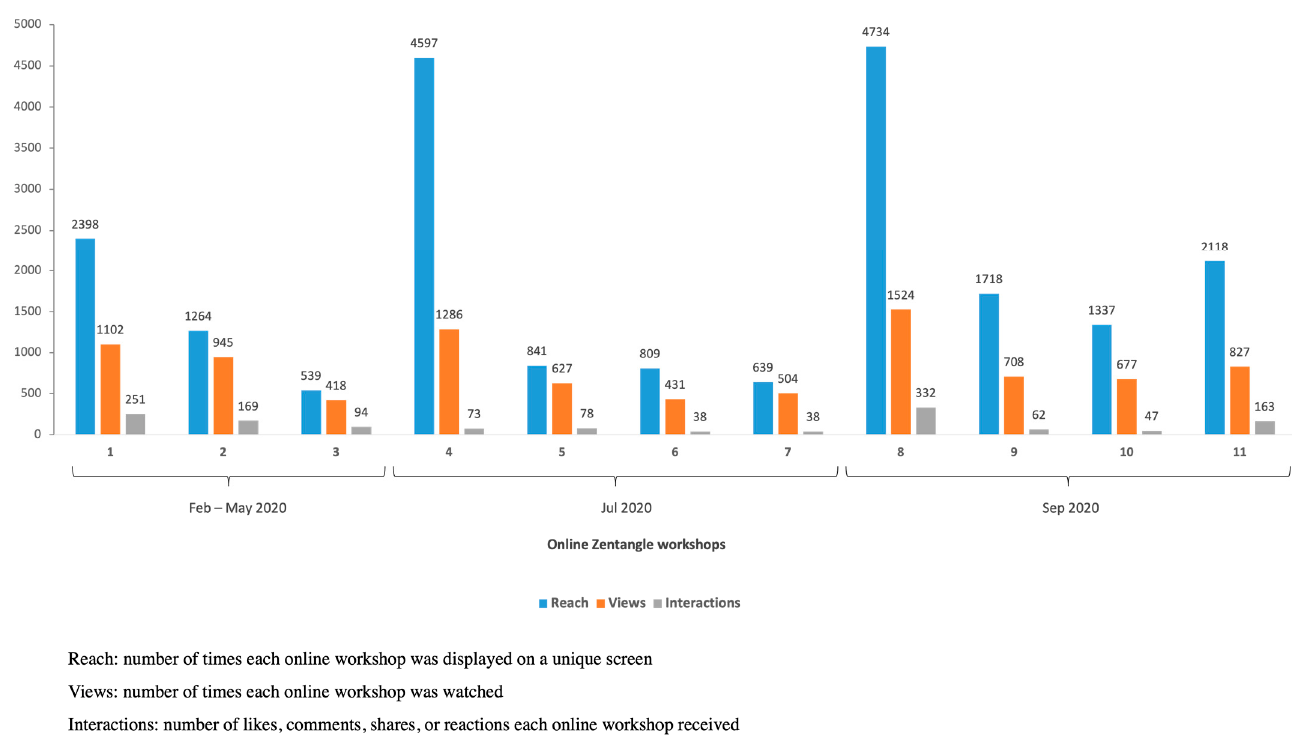
Figure 3. Overview of Facebook Live reach, views, and interactions of 11 online Zentangle workshops.